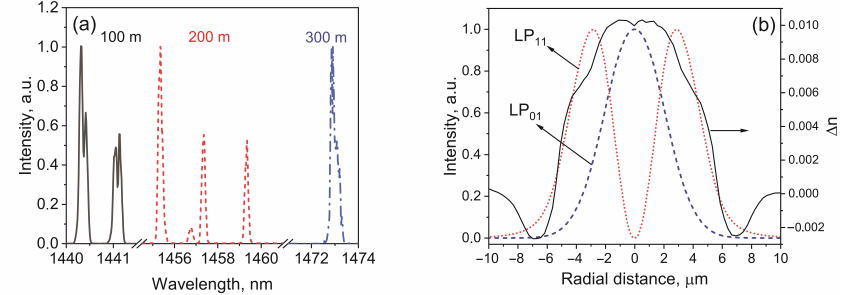
Figure 4. ( a ) The obtained laser lines of the BDFLs operating in a free-running regime. ( b ) Measured refractive index profile of the BDF and calculated radial distribution of LP 01 and LP 11 mode intensities.